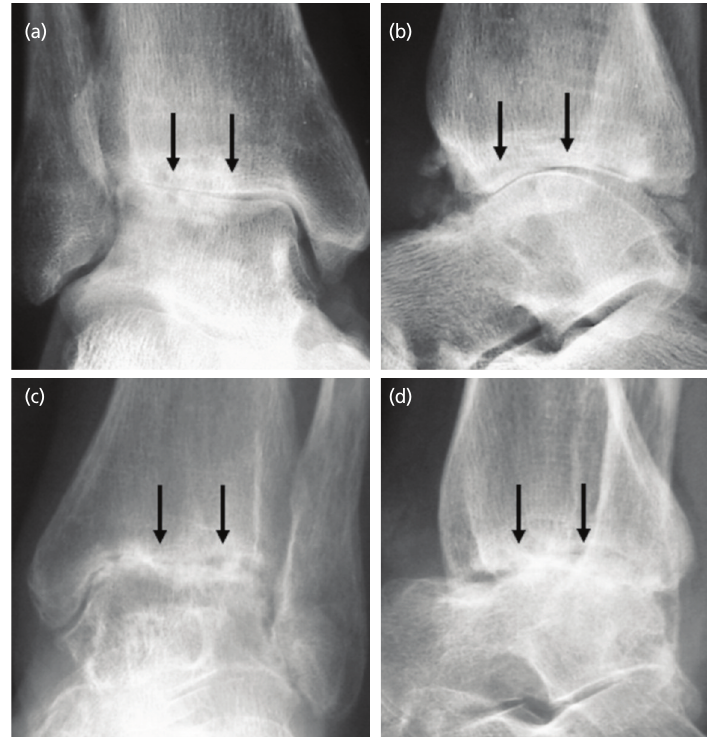
(a) Anteroposterior and (b) lateral radiographs of the right ankle joint of the second case with (c, d) corresponding views of the Fig. 2: left ankle joint of the third case. Arrows showing advanced arthritic changes.